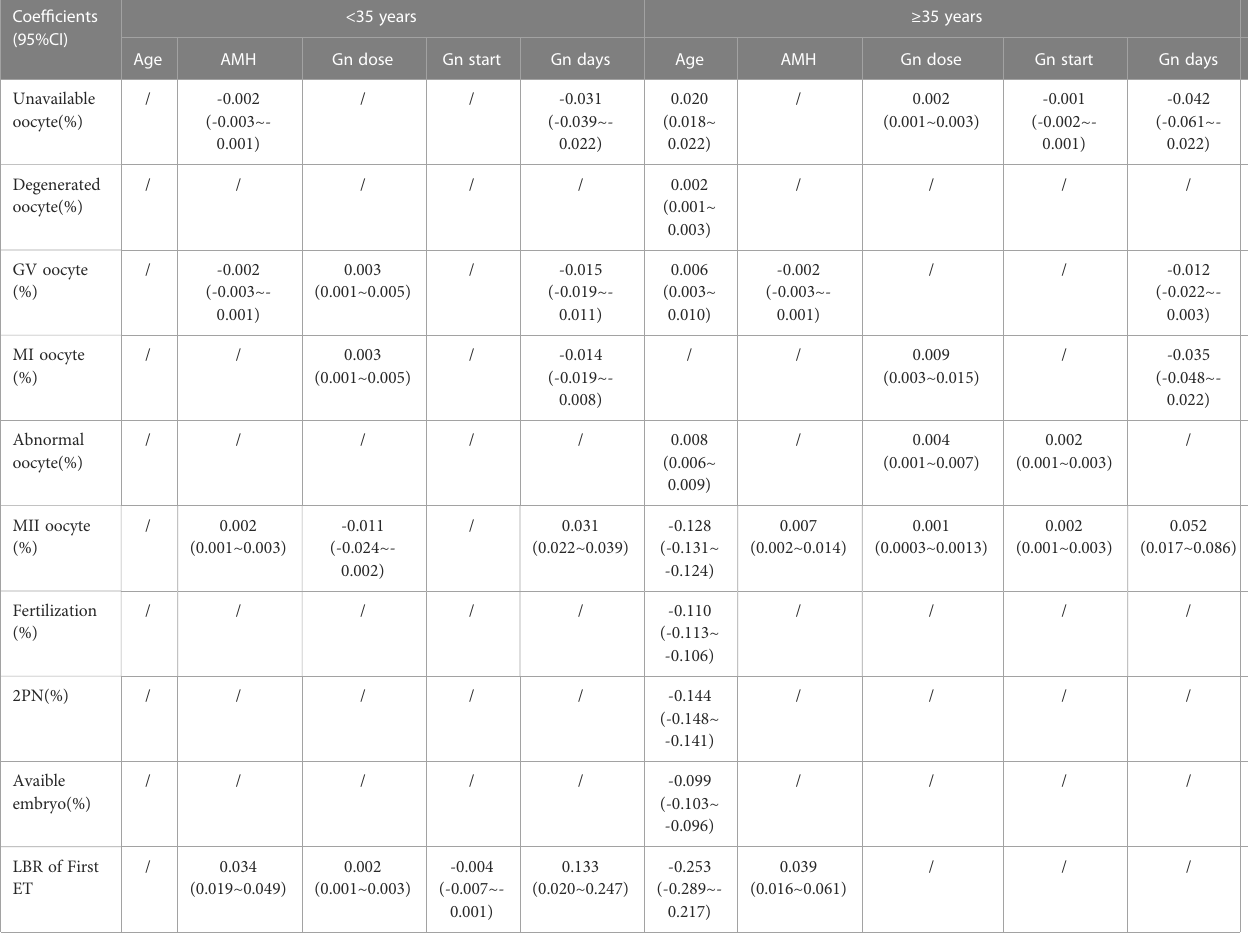
TABLE 6 Factors in fl uencing oocyte and embryology quality between groups. Coef fi cients